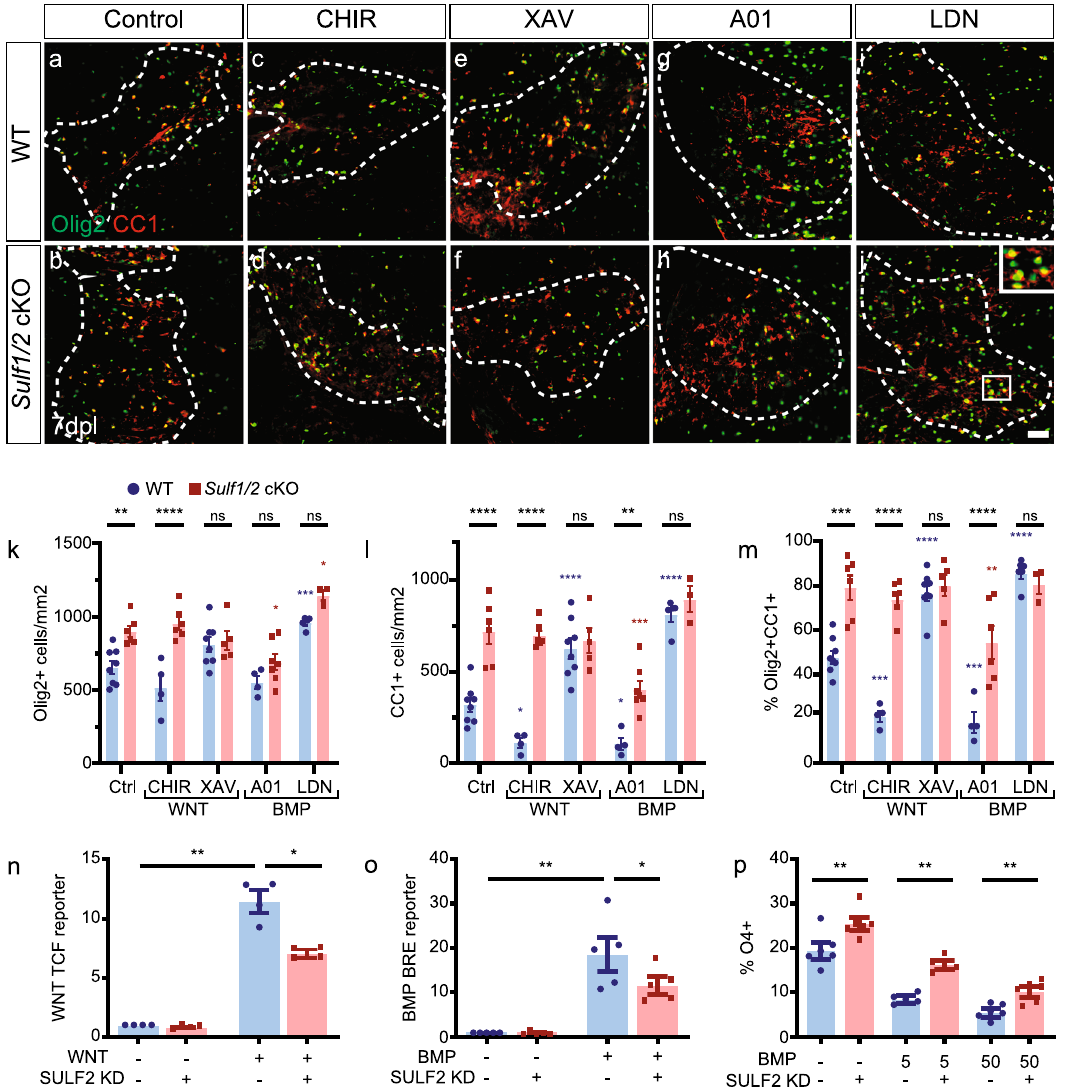
Fig. 5 Sulfatase promotes inhibitory WNT and BMP signaling on oligodendrocyte differentiation following demyelination. Pharmacological manipulation of WNT and BMP signaling was performed in the context of Sulf 1/2 cKO. WNT pathway activator (CHIR-99021, 3 µ M), WNT antagonist (XAV939, 100 nM), BMP pathway activator (A01, 100 nM), or receptor antagonist (LDN-193189, 100 nM) were co-injected with lysolecithin. a – j Oligodendrocyte lineage cell density was assessed by Olig2 (green) and CC1 (red) wide fi eld immuno fl uorescence. Density of Olig2 + oligodendrocyte lineage cells ( k ), Olig2 + CC1 + postmitotic oligodendrocyte ( l ), and percentage of CC1 + oligodendrocytes ( m ) quanti fi ed ( k – m , n = 8, 5, 4, 6, 8, 5, 4, 7, 5, and 3 mice from left to right, for ctrl, CHIR, XAV, A01, and LDN treatment groups, in WT and Sulf1/2 cKO mice respectively). Two-way ANOVA was performed (see Source data for full details). Holm – Sidak multiple comparisons tests vs. ctrl wild-type (blue *) or ctrl Sulf1/2 cKO (red *), or as indicated. *, **, ***, and **** indicated p < 0.05, <0.01, <0.001, and <0.0001 respectively. n hOPCs were co-infected with lentiviral SULF2 shRNAi or scrambled control and lentiviral TCF/LEF reporter virus and exposed to WNT3A (50 ng/mL) or vehicle control. Two-way RM ANOVA followed by Holm – Sidak post-test ( n = 4 fetal human samples, mean ± SEM normalized to control). o hOPCs infected with lentiviral BMP reporter and SULF2 KD virus. SULF2 KD reduced